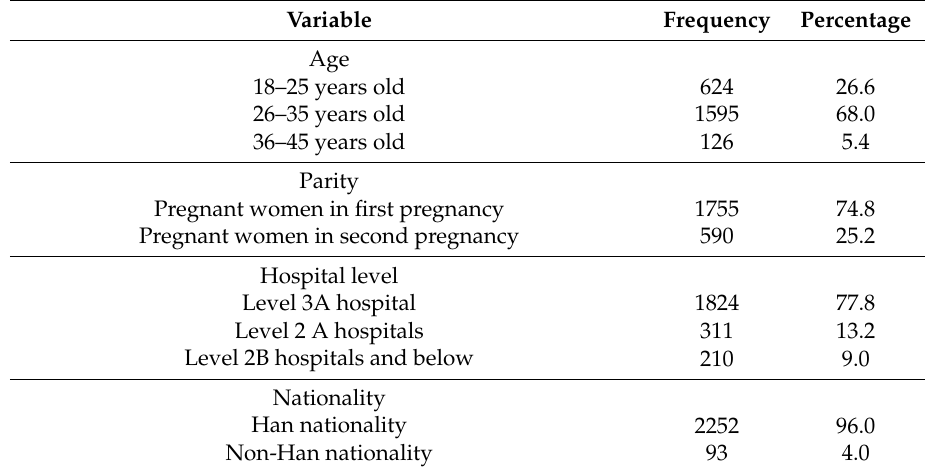
Table 1. Characteristics of the study participants in Chongqing, China, 2015 ( n ,